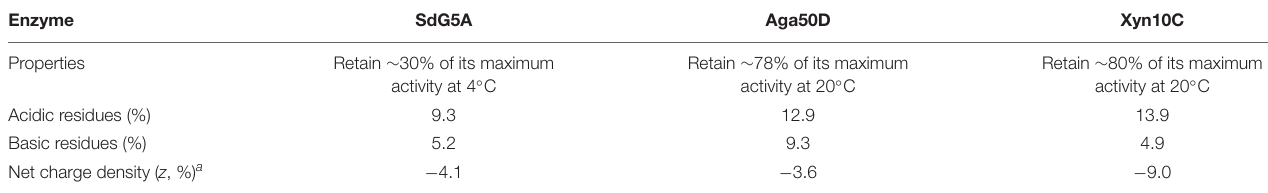
TABLE 3 | Properties of the cold-adapted enzymes from Sde 2-40 and the frequencies of charged amino acid residues for CBM. Enzyme SdG5A Aga50D Xyn10C Properties Retain ∼ 30% of its maximum Acidic residues (%) Basic residues (%)